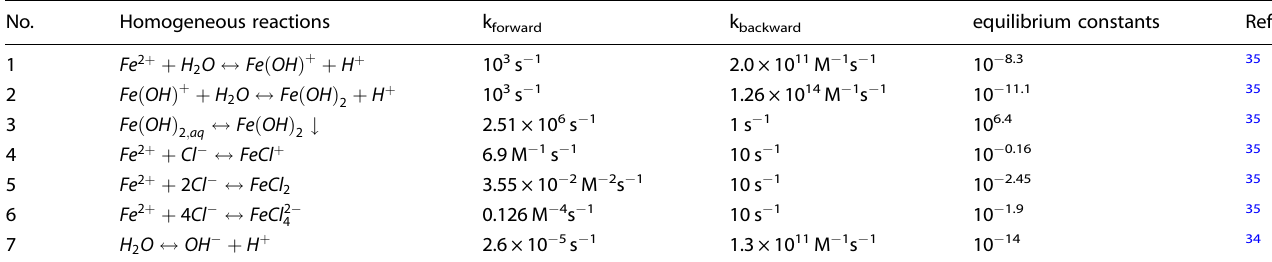
Table 1. Homogeneous reactions and the corresponding kinetic parameters (298 K). No. Homogeneous reactions k forward k backward equilibrium constants